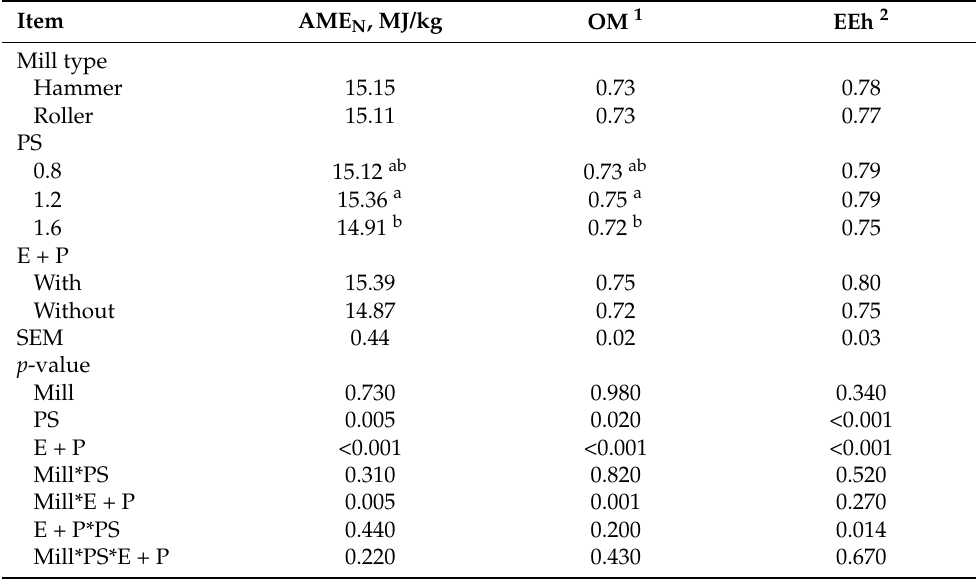
Table 10. Results for 36-day-old broilers showing apparent total-tract nutrient digestibility coefficients from a finisher broiler diet ground using two types of mill at three particle sizes (PS), submitted to conditioning with or without expander (E + P) prior to pelleting.